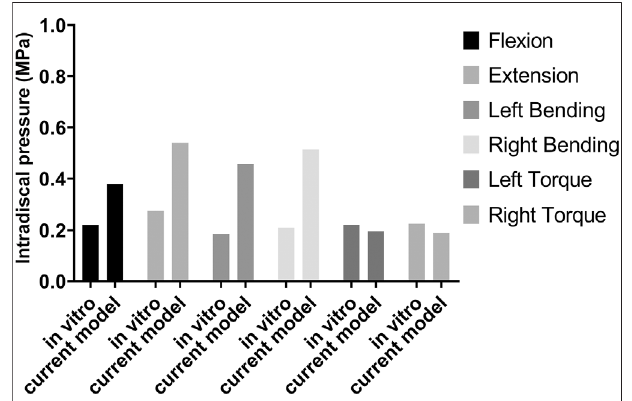
FIGURE 5 | Intradiscal pressure (IDP) of the L4/5 disc for model validation by comparing the in vitro study and current